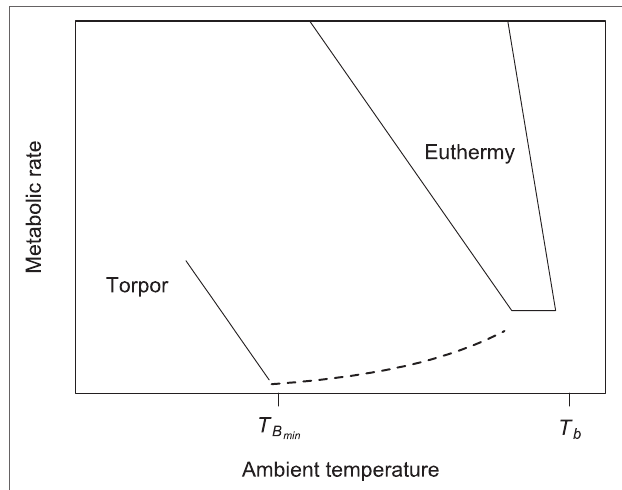
FIGURE 1 | A thermoregulatory polygon of a hibernator, showing the metabolic curve of torpor and the critical body temperature where animals start thermoregulating in torpor ( T Bmin ; see text for details, modified from Rezende and Bacigalupe,